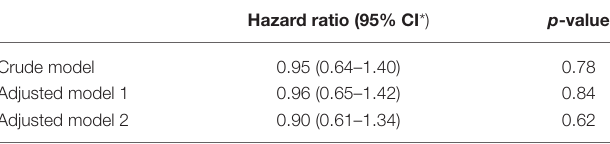
TABLE 2 | Multivariable analysis on the association of window group and delirium with event.